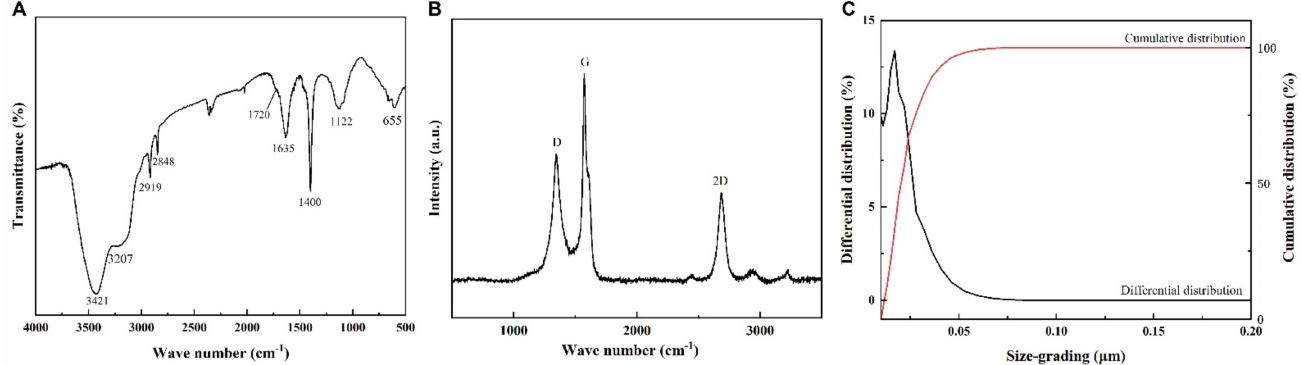
Figure 3. Composition and structure analyses of graphene. ( A ) FT-IR spectra of graphene, ( B ) Raman spectra of graphene, and ( C ) size distribution of